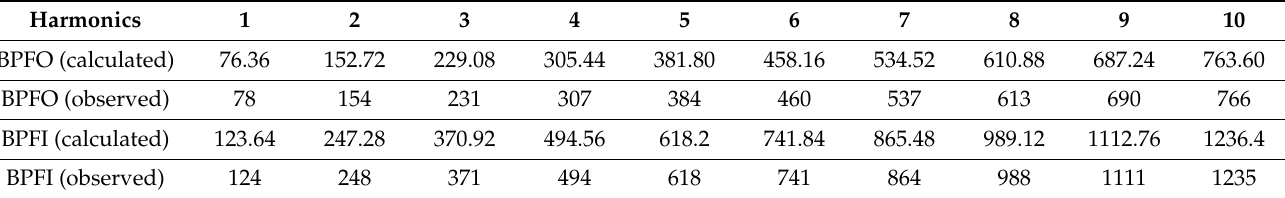
Table 7. Calculated bearing fault characteristic frequency harmonics for State 3.